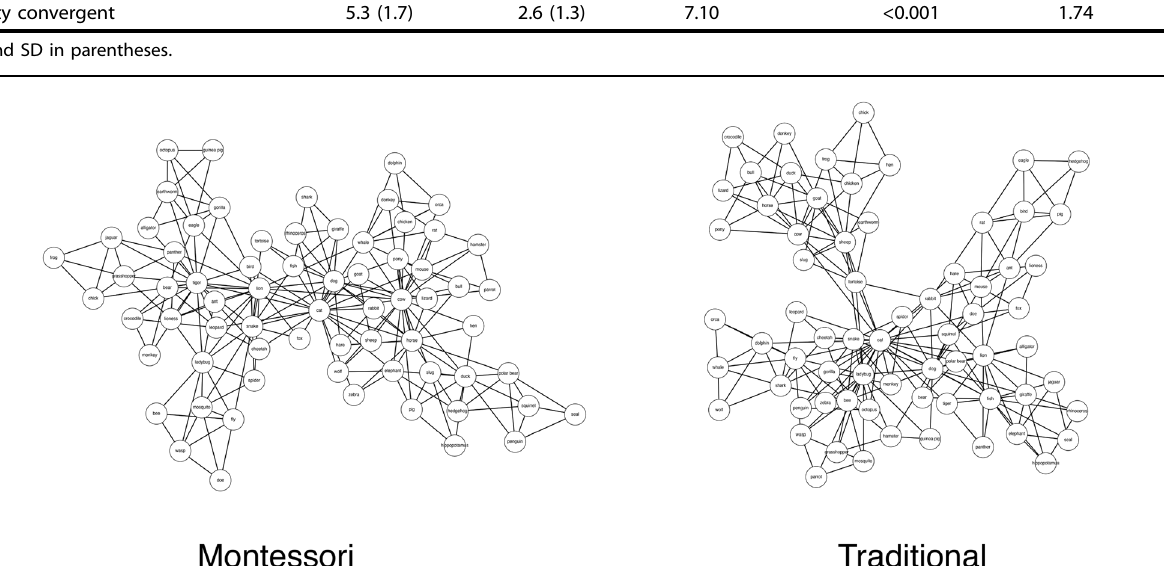
Fig. 1 Semantic Network. 2D Visualization of the semantic networks of the Montessori and traditional groups.